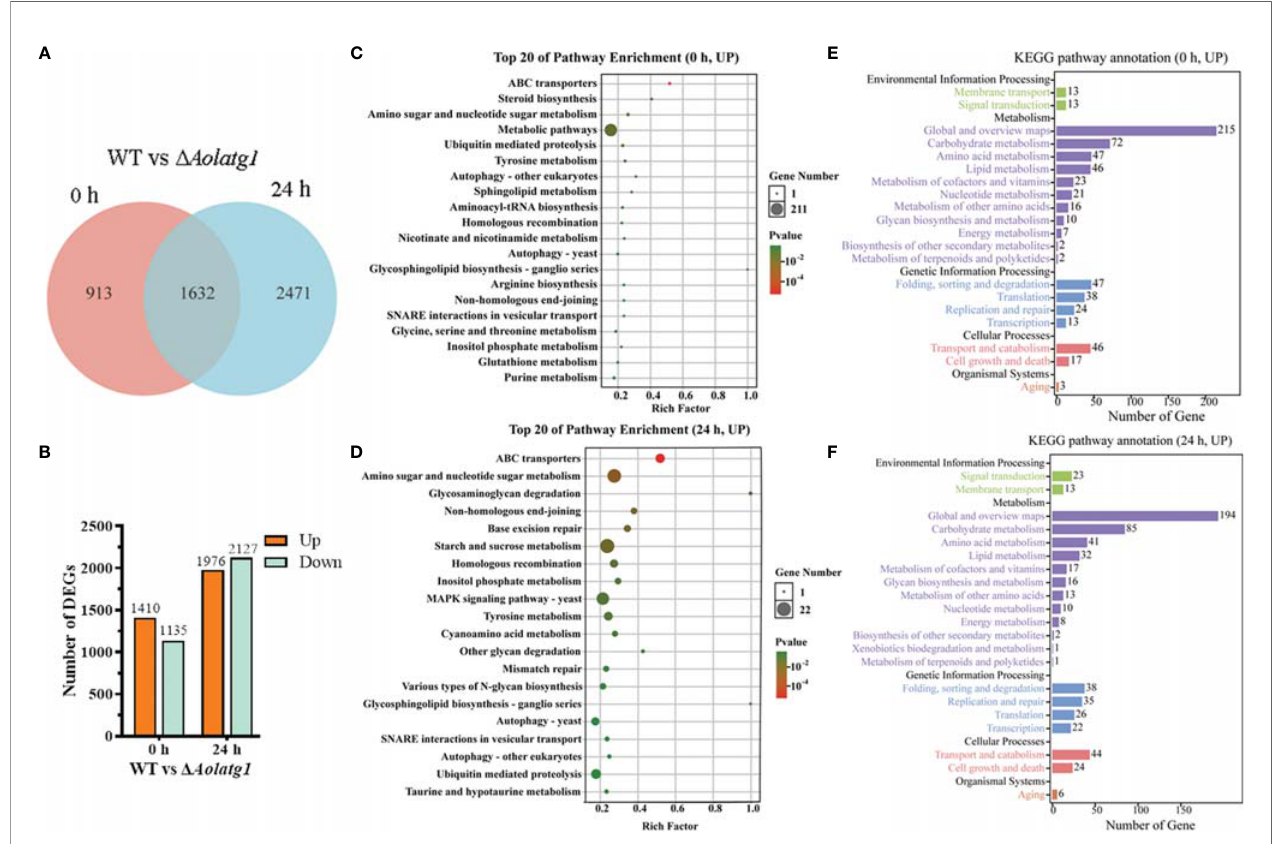
FIGURE 6 | Comparison of differentially expressed genes (DEGs) between WT and the D Aolatg1 mutant strain of A. oligospora . (A) Venn analysis of DEGs. (B) The number of upregulated and downregulated DEGs in the WT versus the D Aolatg1 mutant strains. (C) The top 20 pathways that are upregulated in the WT strain compared to the D Aolatg1 mutant strain at 0 h. (D) The top 20 pathways that are upregulated in the WT strain compared to the D Aolatg1 mutant strain at 24 h. (E) Annotation of the upregulated KEGG pathways in the WT strain compared to the pathways in D Aolatg1 mutant at 0 h. (F) Annotation of the upregulated KEGG pathways in the WT strain compared to the pathways in D Aolatg1 mutant at 24